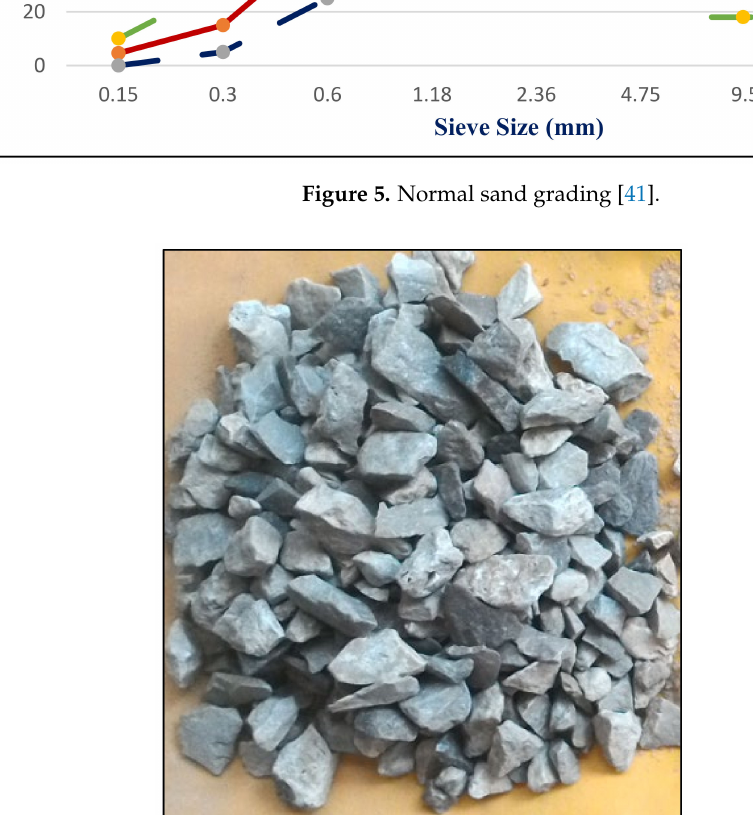
Figure 6. Used Crushed Dolomite.